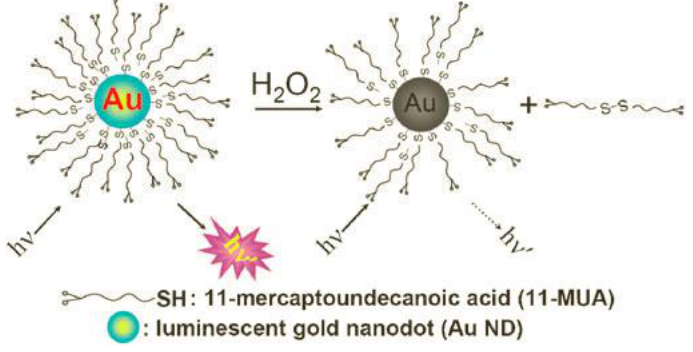
Figure 1. Schematic representation of 11-MUA-Au NDs responding to H 2 O 2 based on the luminescence quenching by ligand release. Reproduced from [12] with permission of The Royal Society of